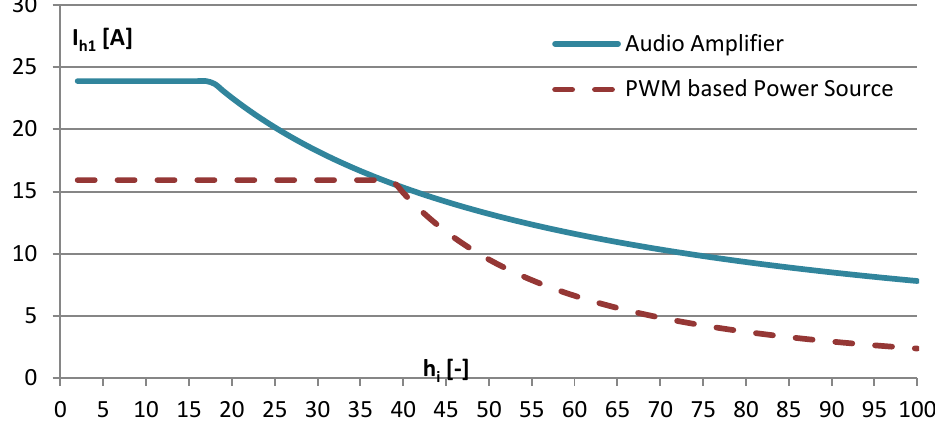
Figure 4. The maximum rms values of the main harmonic of the distorted current for which a higher harmonic of a given frequency may be equal to its 10% level for the tested power sources.